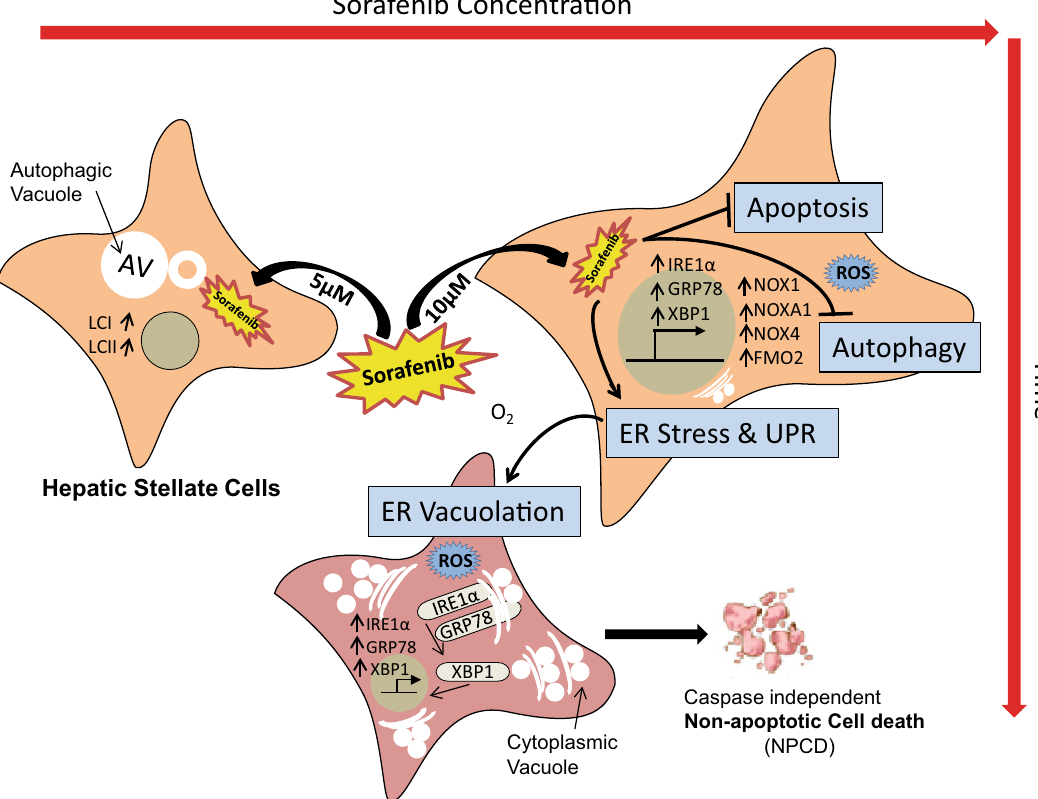
Figure 9. Diagram showing dose dependent sorafenib induced cellular death through ER vacuolation. Therapeutic treatment with sorafenib leads to deactivation of HSCs by means of overlapping cellular processes such as autophagy, apoptosis, and non-apoptotic death. Depending on concentration and duration of sorafenib treatment the activated stellate cells can undergo autophagy. On the other hand, higher concentration